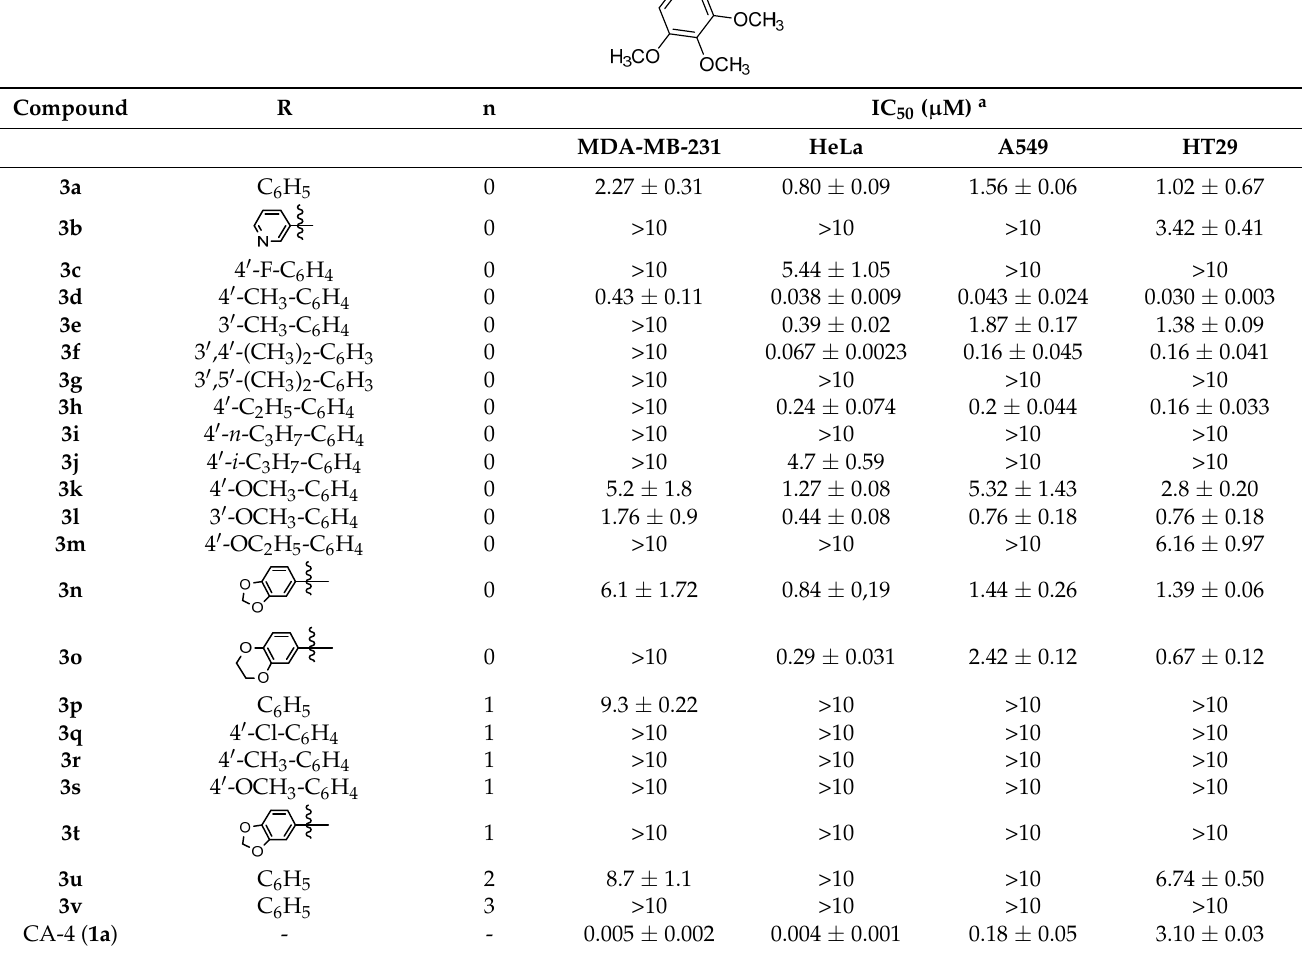
Table 1. In vitro cell growth inhibitory effects of compounds 3a–v and CA-4 ( 1a